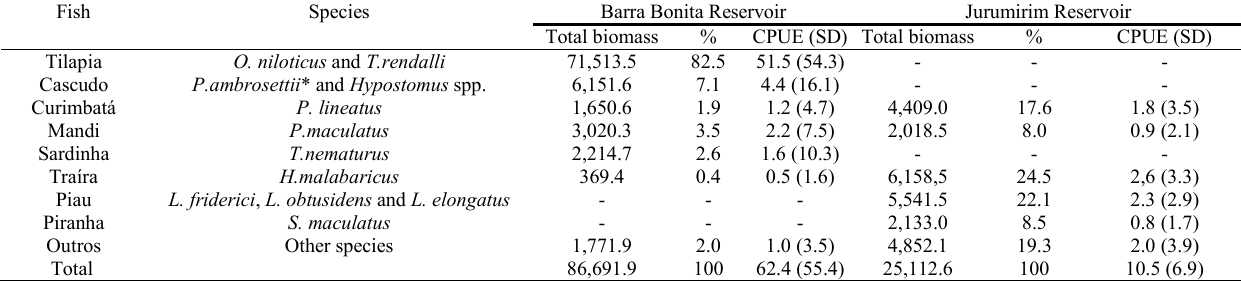
Table 3. Total biomass (kg), relative frequency (%), and CPUE (kg fisher -1 day -1 ) for the main fish caught of artisanal fisheries